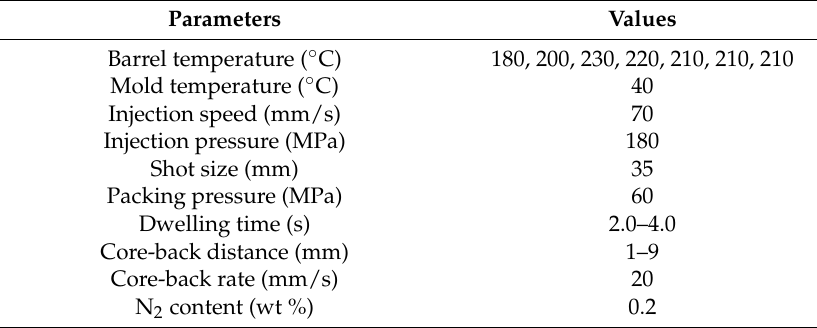
Table 1. Processing conditions for the core-back foam injection molding